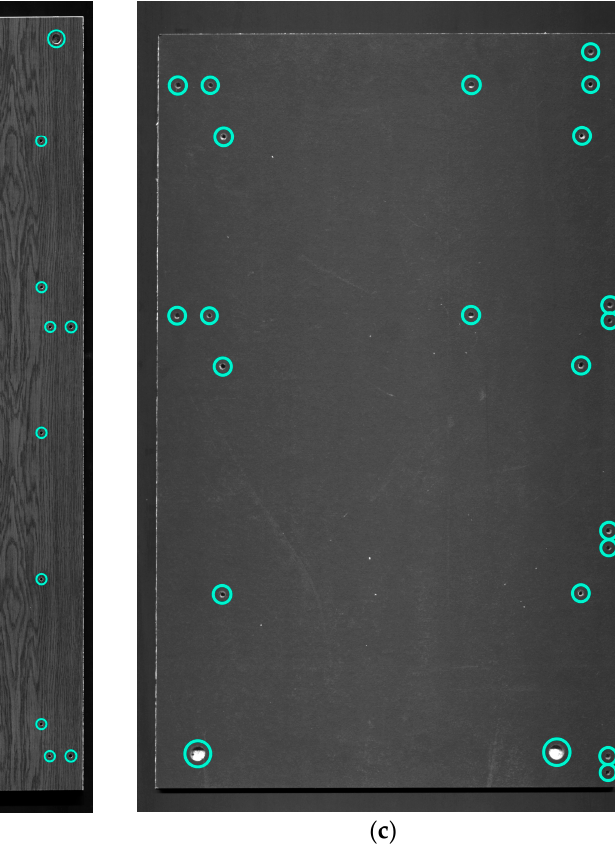
Figure 8. Data example. ( a – c ) different furniture panels in production: ( a ) part with cutout, ( b ) panel with wood pattern imitation, ( c ) black panel.